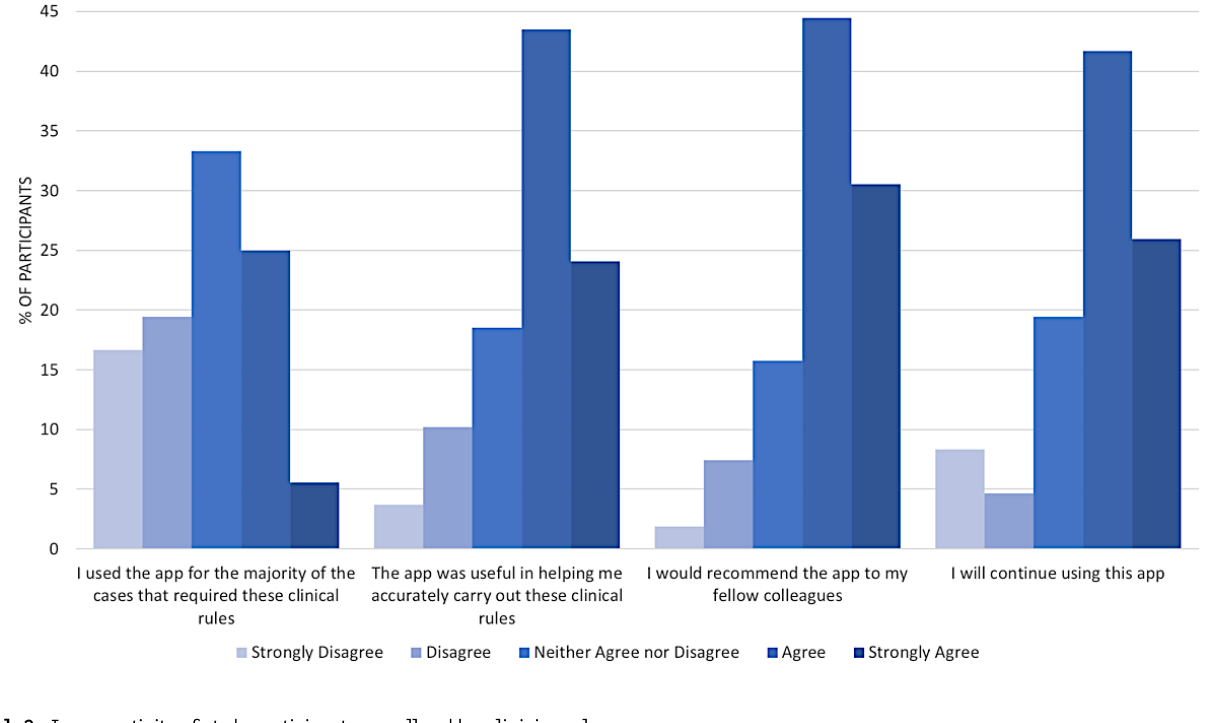
Figure 3. Usability survey responses.